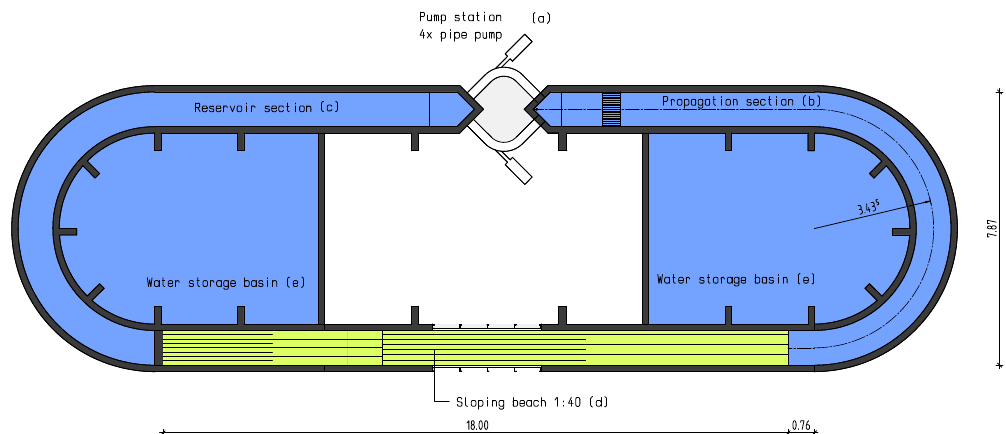
Fig. 2. Schematic drawing of the closed-circuit flume and its equipments, (a) pump station, (b) propagation section, (c) reservoir section, (d) sloping beach, (e) water storage basin (units in metre).